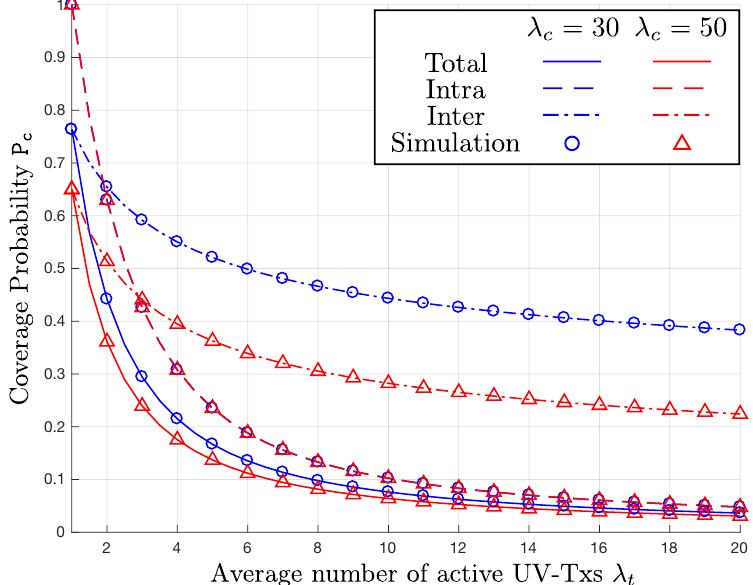
Figure 4. P c versus λ t for λ c = { 30,50 } clusters/km, σ = 5, and β = 0 dB.